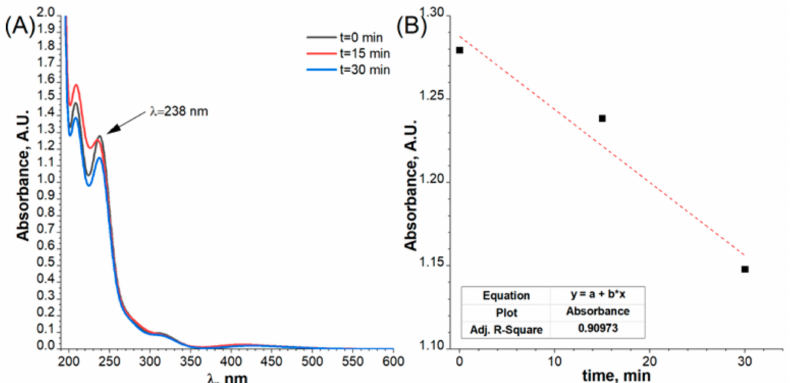
Figure 8. ( A ) UV-Vis spectra of the electrolytes with Pd 2+ ions after galvanic displacement of a flat electrode with different reaction time and ( B ) kinetic plot for Pd decoration of Ni